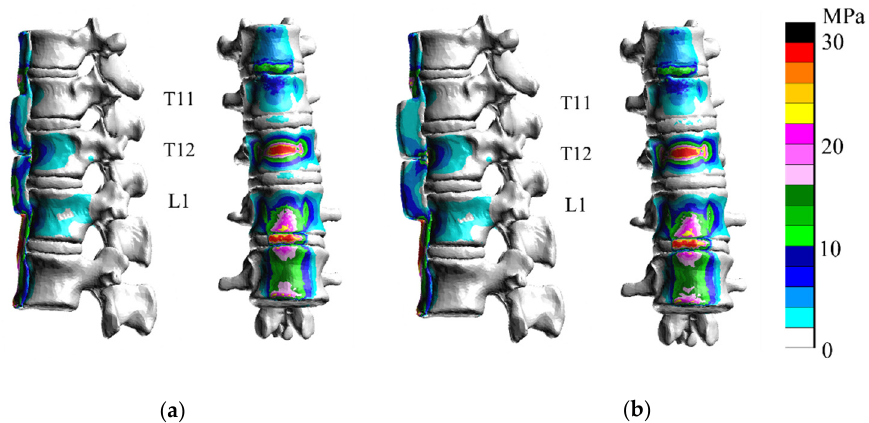
Figure 9. In D-5/R-1 ( a ) and D-10/R-1 ( b ), the stress at the center of T12 increased at the discontinuity in extension.